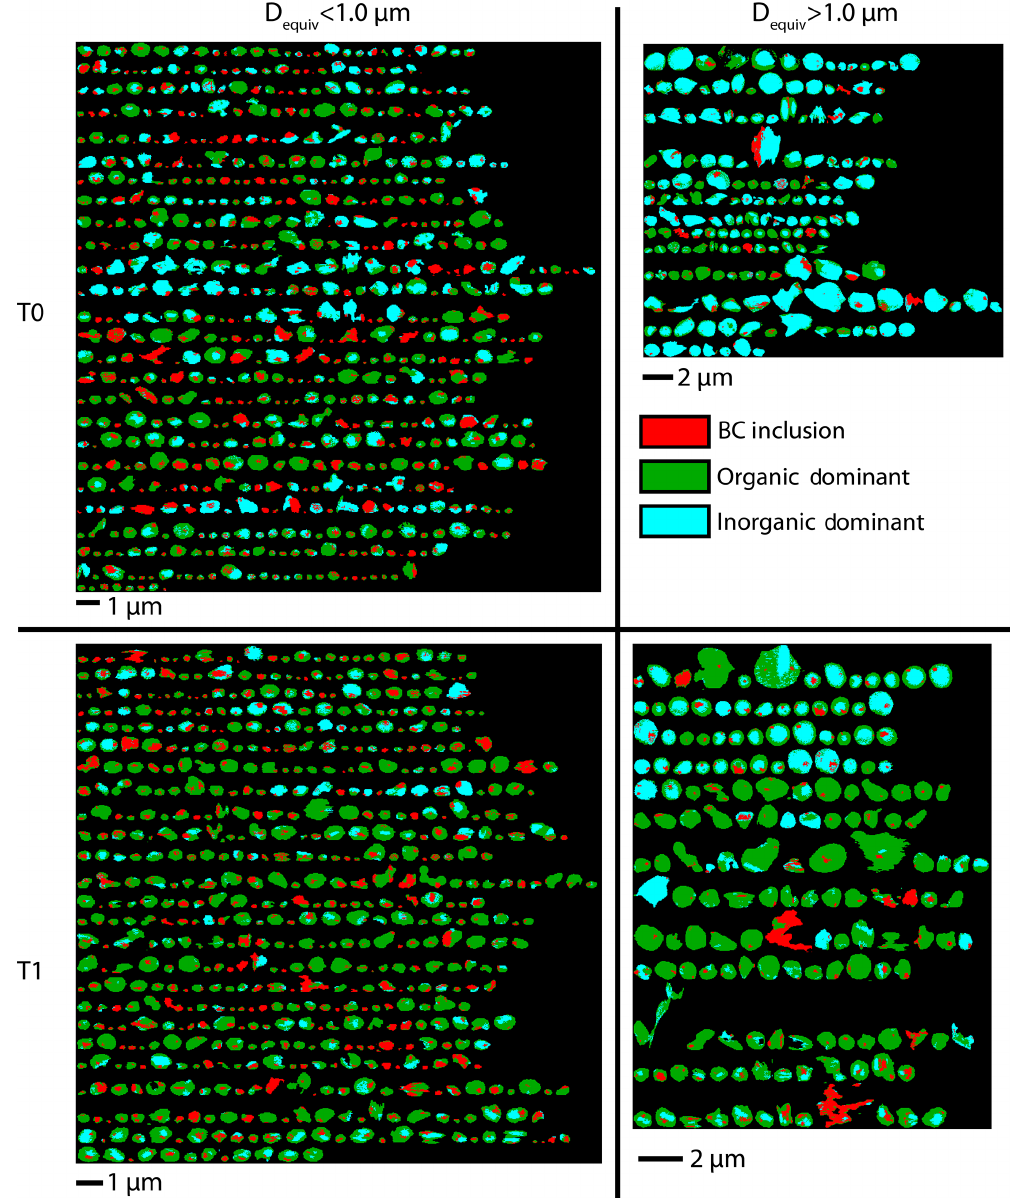
Figure 2. Cropped composition maps for all BC containing particles identified in CARES samples collected at T0 (top) and T1 (bottom). The submicron (left panels) particles are separated from the supermicron particles (right